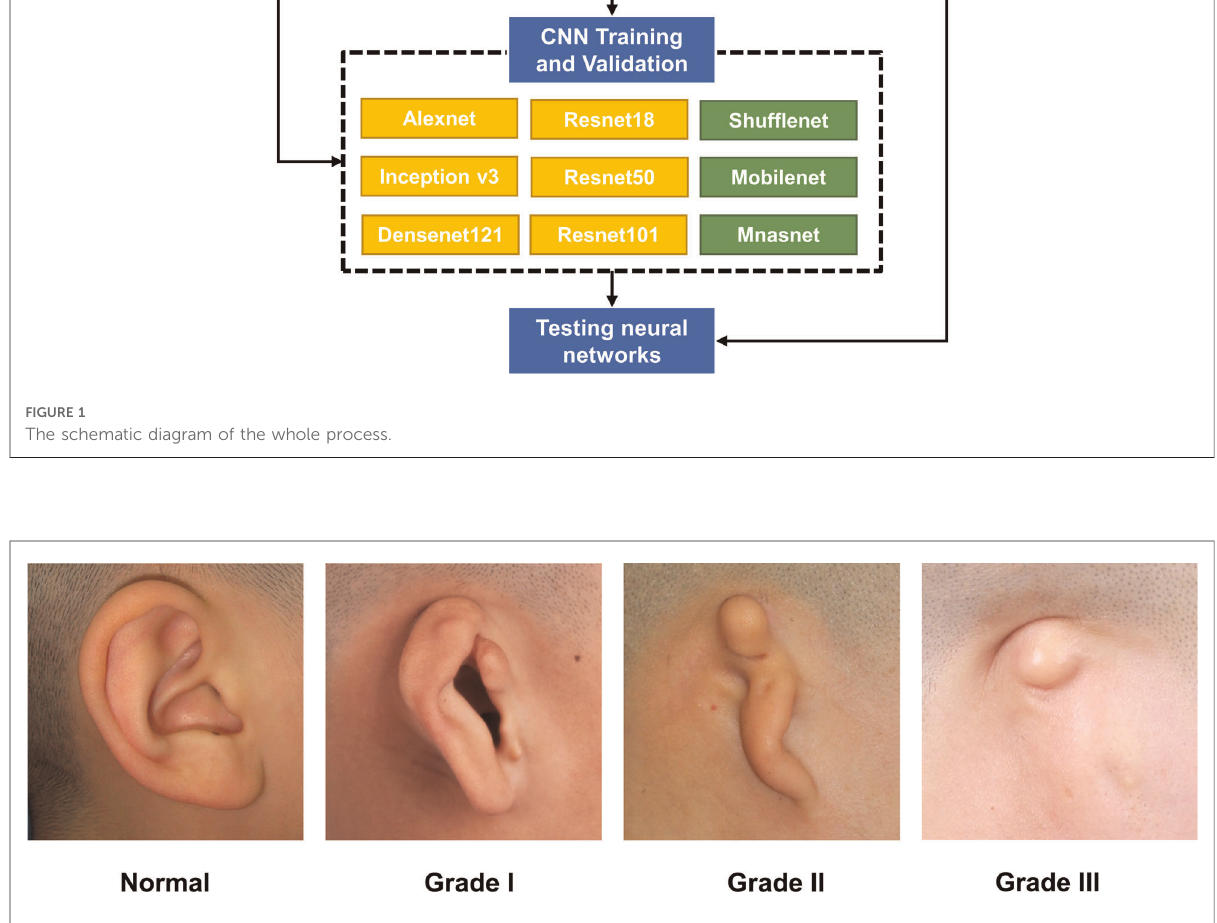
FIGURE 2 The severity assessment of